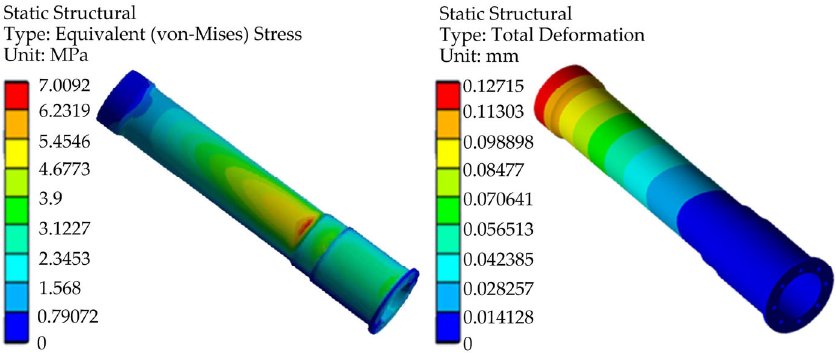
Figure 10. Stress and deformation distribution for the small arm.